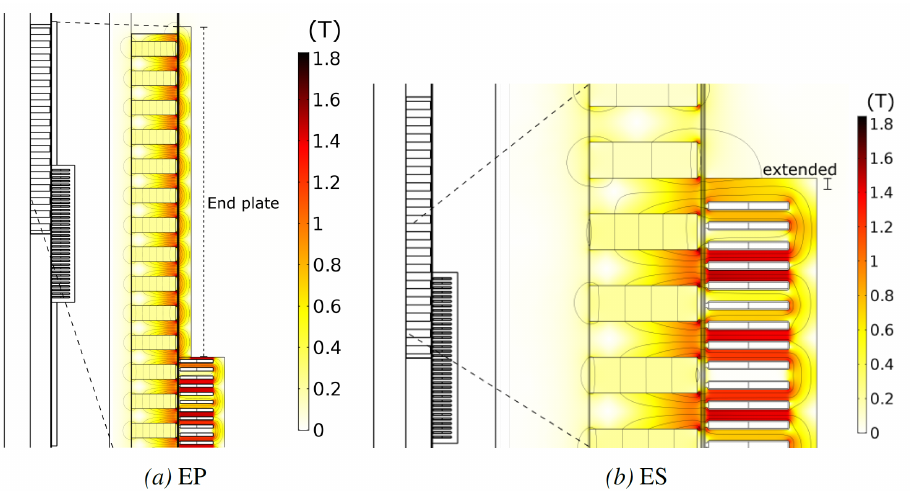
Figure 4. ( a ) End plate (EP) above and below the stator to keep the PMs magnetized and thereby reducing the end forces, and ( b ) extended stator (ES) iron to counter the end forces for full active stator area. The modifications are done to both top and bottom stator